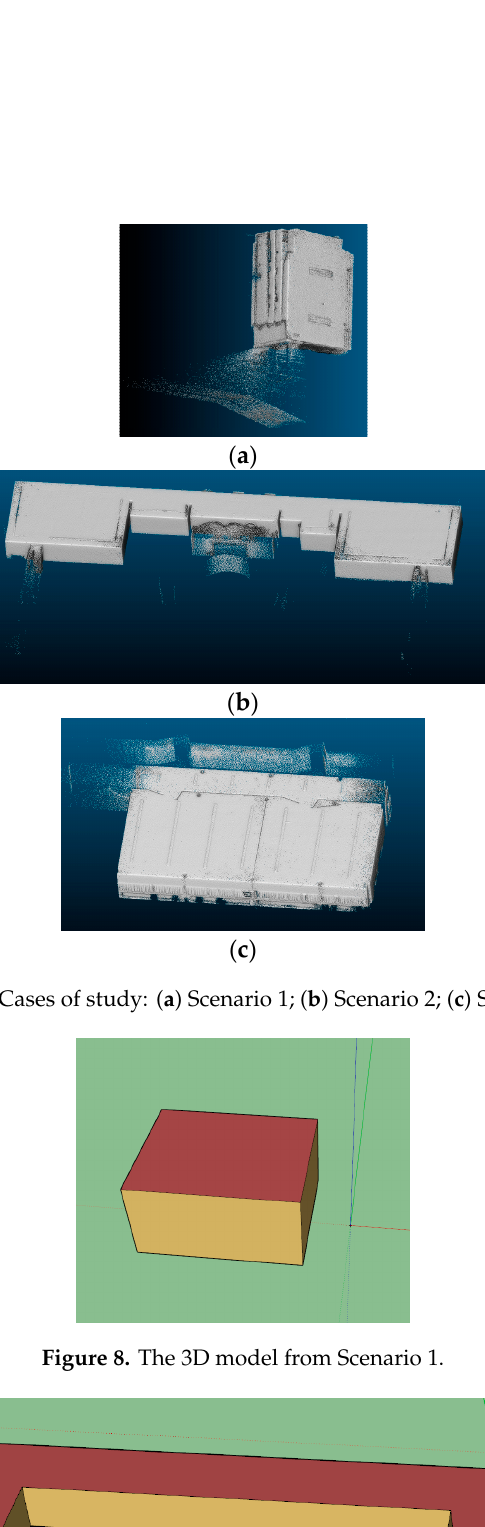
Figure 8. The 3D model from Scenario 1. Figure 9. The 3D model from Scenario Figure 9. The 3D model from Scenario 2.